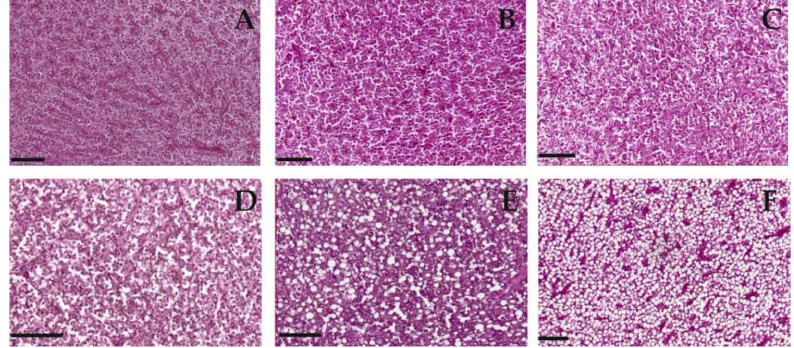
Figure 5. Lipid vacuolisation in liver of ( A – C ) S. cephalus and ( D , E ) P. bonelli caught in the three different rivers with ( A , D ) very low, ( B , E ) low, and ( C , F ) high concentration of PFAS. Increasing vacuolisation was observed only in P. bonelli liver, and it was proportional to increasing hepatic PFAS concentration (from 139.25 µ g/kg per whole body weight). Scale bars indicate 50 µ m. Six specimens per